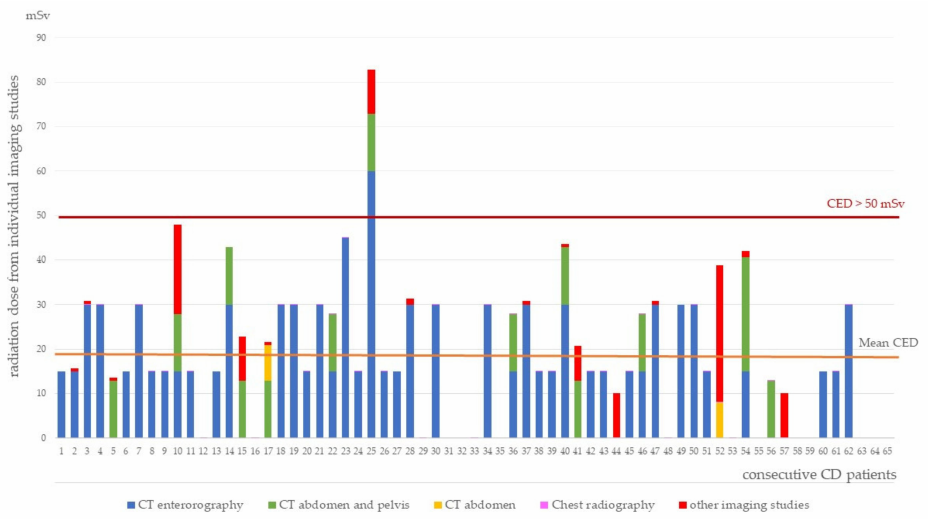
Figure 2. Cumulative effective dose in patients with Crohn’s disease. Mean CED was also assessed depending on CD locations and behavior and UC extension, which is presented in Figure 4. We noticed that the localization of CD has no influence on CED. However, patients with structuring and penetrating disease absorbed significantly more radiation compared to patients with non-stricturing/non-penetrating disease. Exposure was significantly lower among patients with ulcerative proctitis and left-sided colitis than among those with extensive